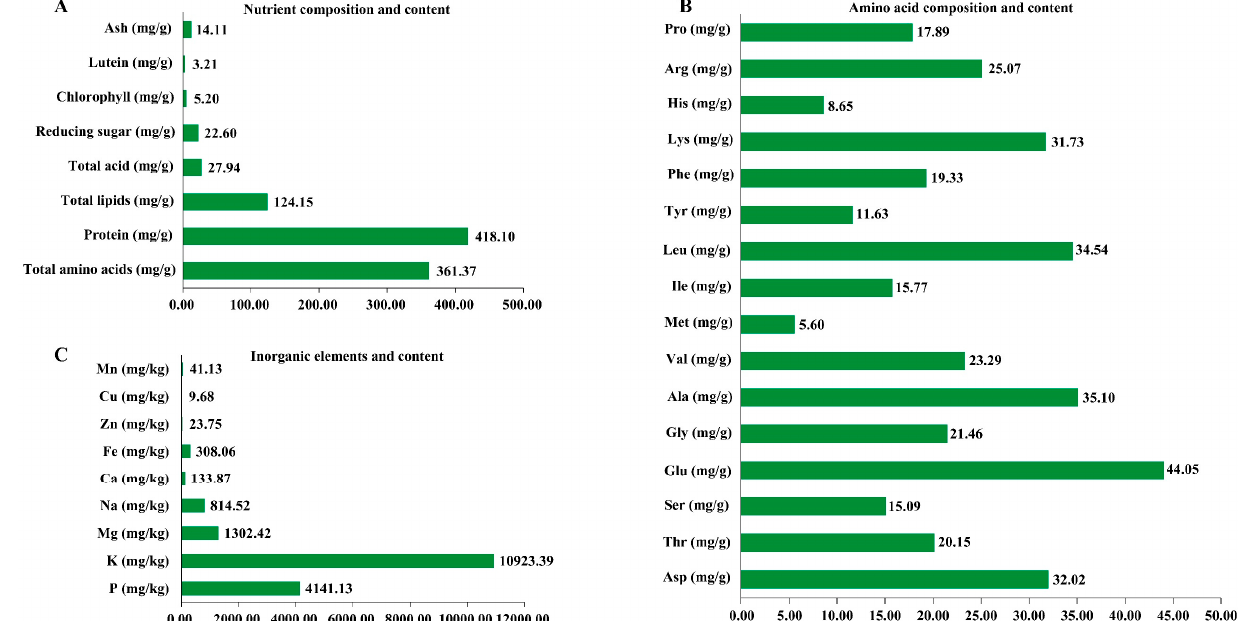
Figure 1. Nutritional composition and content of Chlorella sorokiniana DP-1. ( A ) Nutrient composition and content of Chlorella sorokiniana DP-1. ( B ) Amino acid composition and content of Chlorella sorokiniana DP-1. ( C ) Inorganic element and content of Chlorella sorokiniana DP-1. Chlorella sorokiniana DP-1 was cultured for 10 days, and the precipitated algae cells were collected by centrifugation. Nutritional compositions and contents were analyzed after